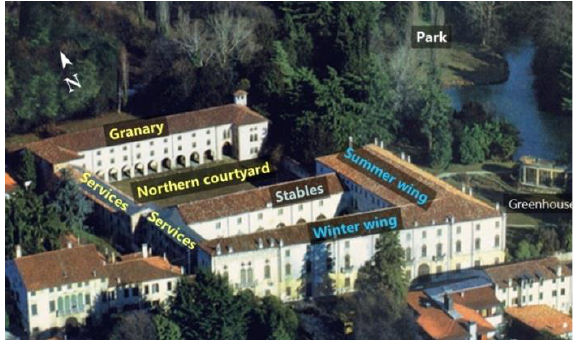
Figure 3: Perspective view of Villa Revedin-Bolasco